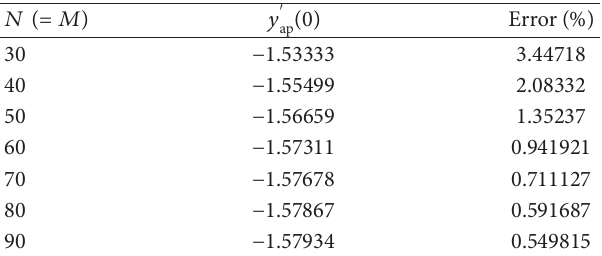
T 4: Approximations of the initial